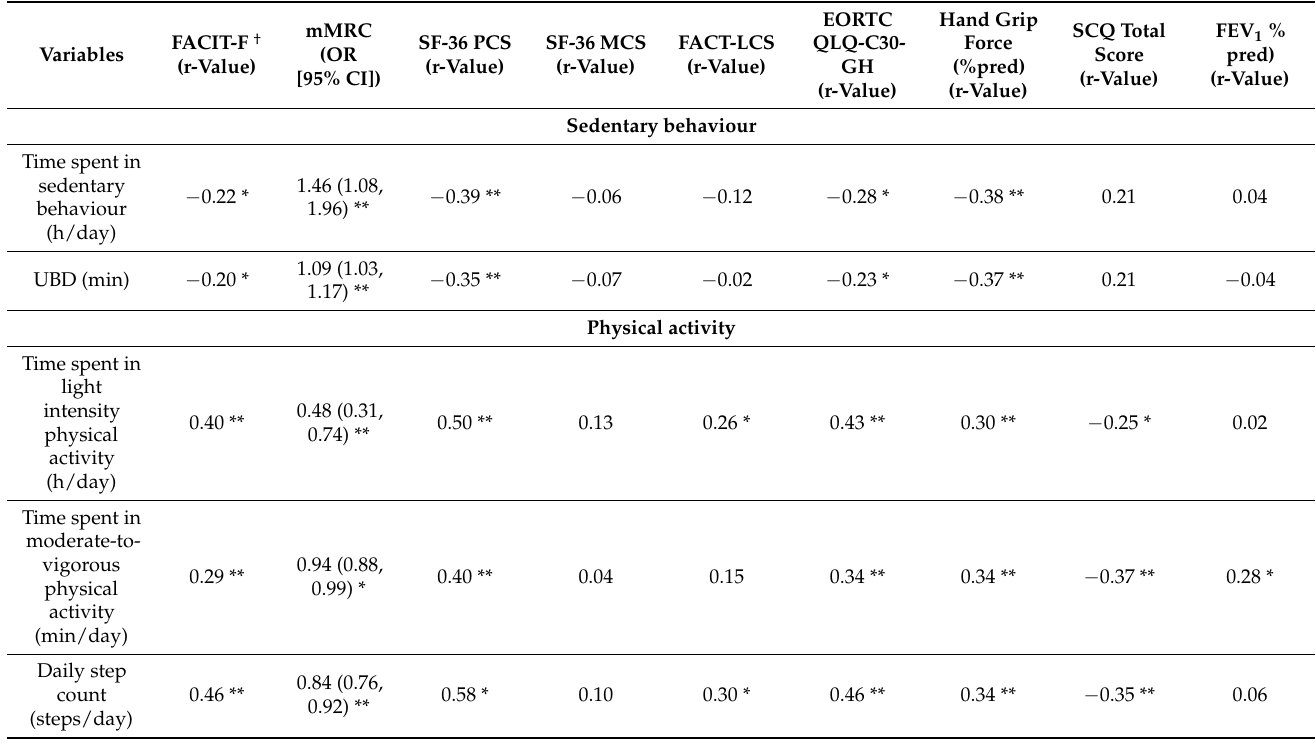
Correlations (either r-values or unadjusted odds ratio) between sedentary be- haviour/physical activity variables and symptoms (FACIT-F and mMRC), HRQoL, muscle force, comorbidities, and lung